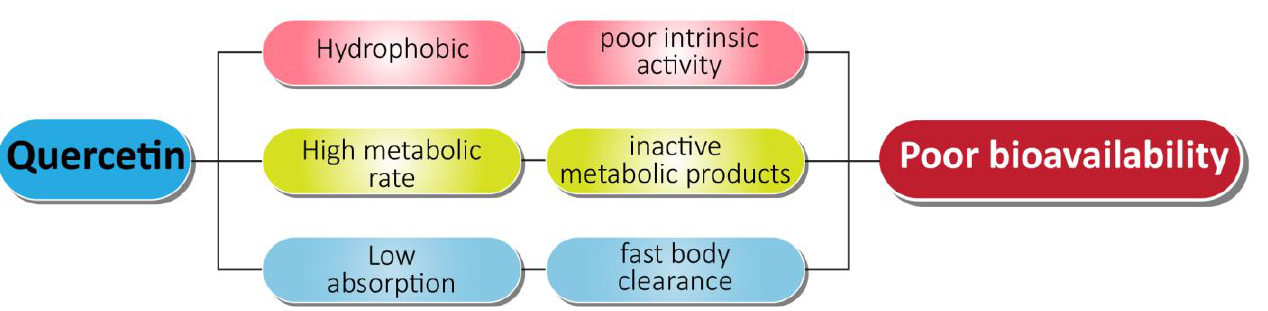
Figure 6. Associated problems with quercetin as an anti-prostate cancer agent.